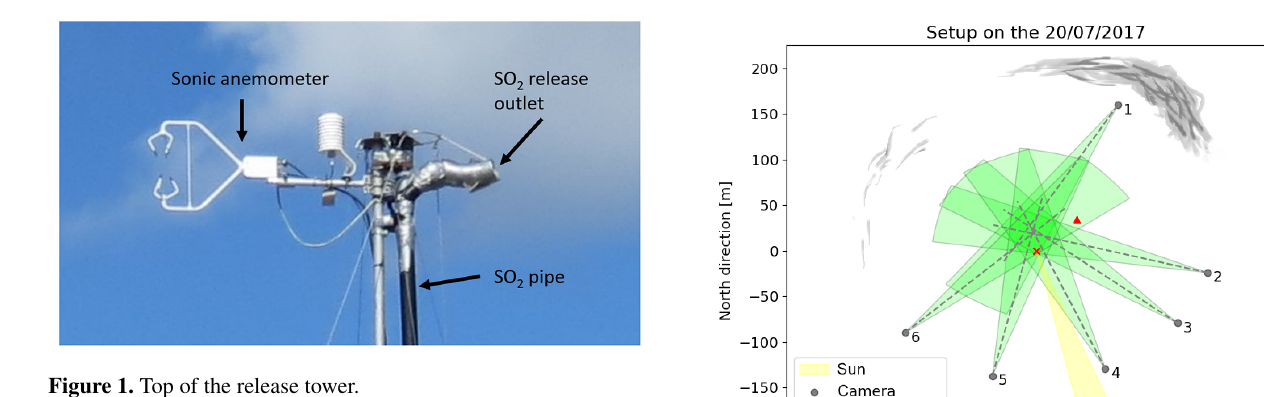
Figure 1. Top of the release tower.